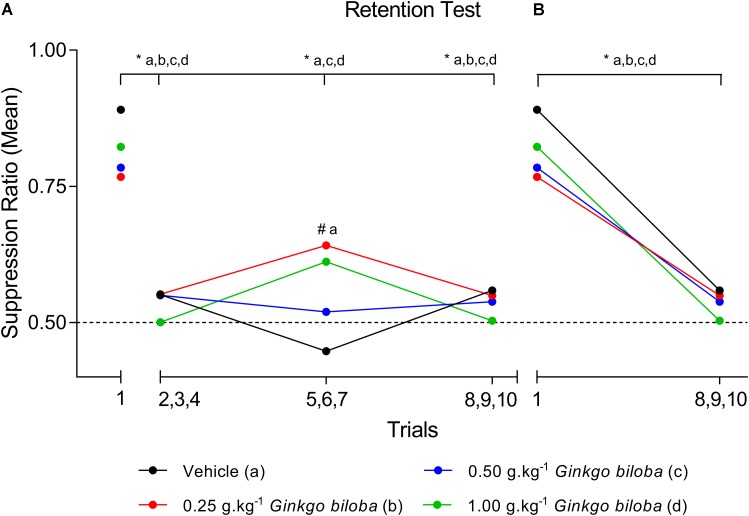
SR means of conditioned lick suppression during the retention test session (day 8). The points indicate the SR means of the first trial and the three-trial blocks for the control (vehicle) and EGb-treated (0.25, 0.50, and 1.00 g⋅kg−1) groups (n = 6 per group) (A) and first trial versus last three trial block (B). Data represent mean. ∗P < 0.05 (two-way repeated measures ANOVA–Tukey post hoc test). #Comparison among groups; ∗comparison intragroup.